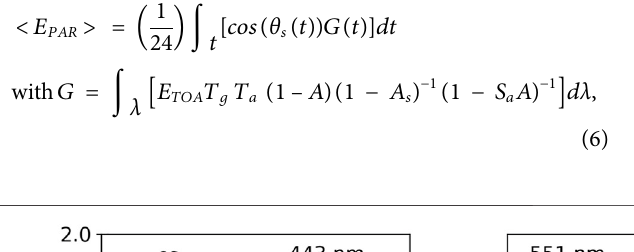
Frontiers in Remote Sensing |